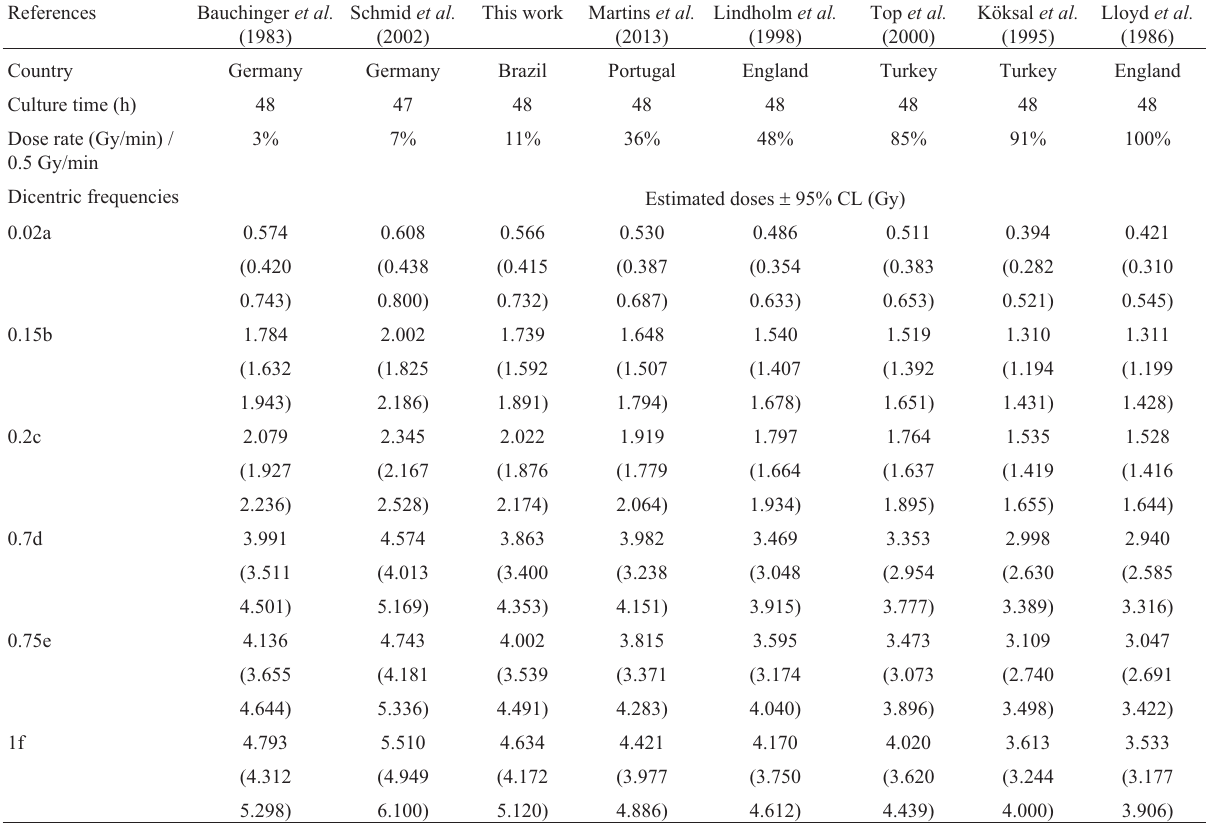
Table 3 - Comparison of estimated absorbed doses by selected calibration curves using Dose Estimate